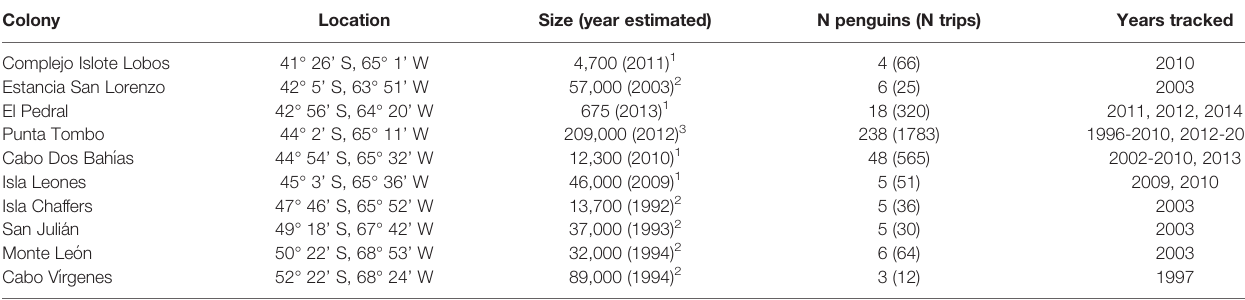
TABLE 1 | Colony and tracking details for Magellanic penguins at 10 colonies in Argentina. Colony Location Size (year estimated) N penguins (N trips) Years tracked Complejo Islote